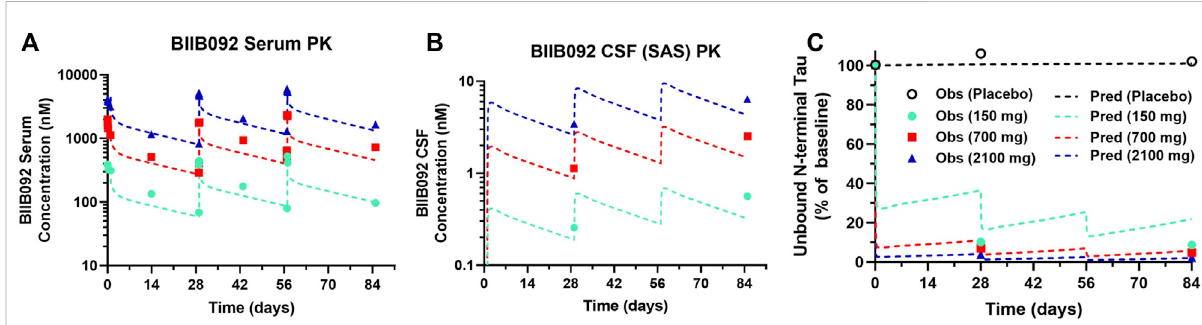
FIGURE 3 PBPK-PD model predictions overlayed with clinical BIIB092 pharmacokinetics and pharmacodynamics data. (A) Serum and (B) CSF concentrations of BIIB092 and (C) unbound N-terminal tau concentrations in CSF (relative to baseline). Three doses of BIIB092, 150, 700, and 2100 mg IV are depicted in cyan, red, and dark blue, respectively. Observed (Obs) data are represented as markers and model predictions (Pred) are represented by dashed